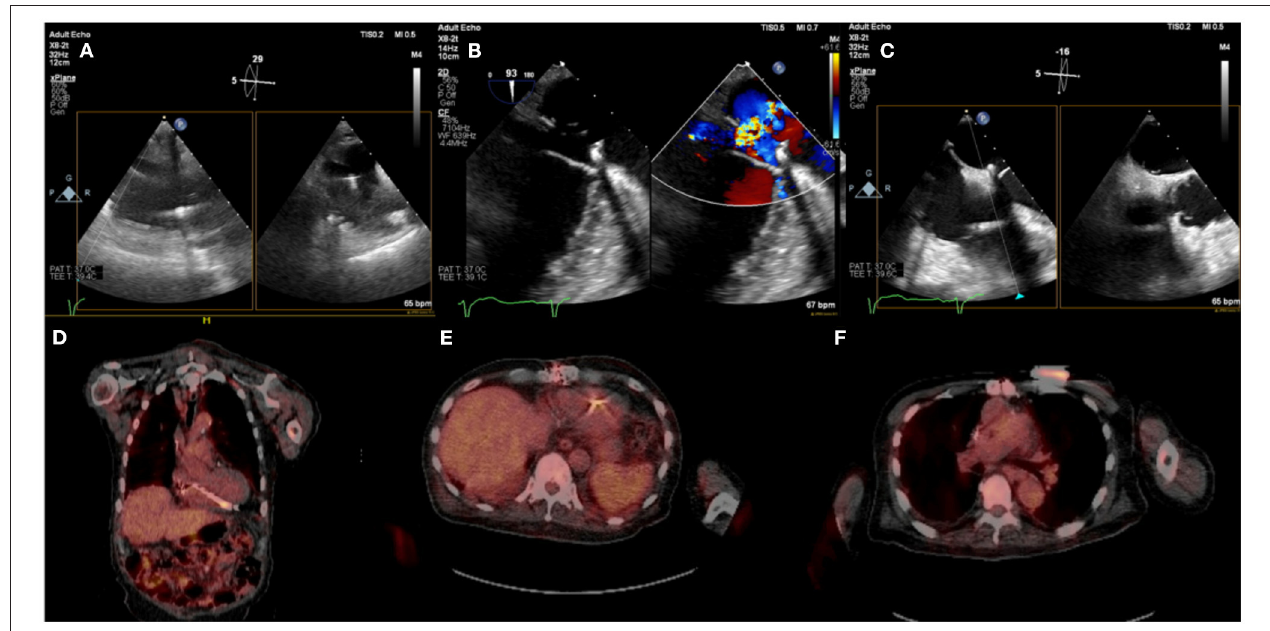
FIGURE 4 | Eighty five year-old male with history ischemic cardiomyopathy s/p dual-chamber ICD for primary prevention, history of CABG and mitral valve repair presented with persistent MRSA bacteremia. TEE showed small linear echodensities attached to right atrial lead (A) , multiple small echodensities attached to mitral ring and moderate mitral regurgitation (B) . The RV showed no vegetations with normal tricuspid valve (C) . 18 F-FDG PET-CT was obtained to assess extent of infection and showed focal uptake along the RV lead (D,E) . Left chest wall ICD showed focal uptake but no pocket uptake to suggest pocket infection (F) . The patient was deemed to have a prohibitive risk for redo cardiac surgery and was treated medically. He passed away 2 months after the diagnosis of CIED systemic infection with MRSA